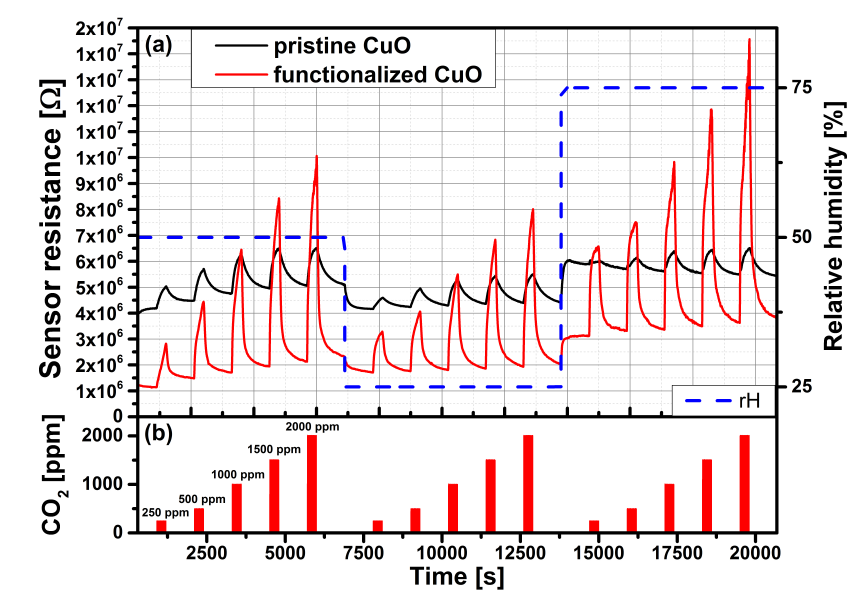
Figure 6. ( a ) Carbon dioxide measurement of the pristine and functionalized CuO gas sensors at an operation temperature of 300 ◦ C and rH levels of 25%, 50% and 75%. ( b ) CO 2 gas pulses: 250 ppm, 500 ppm, 100 ppm, 1500 ppm and 2000 ppm.